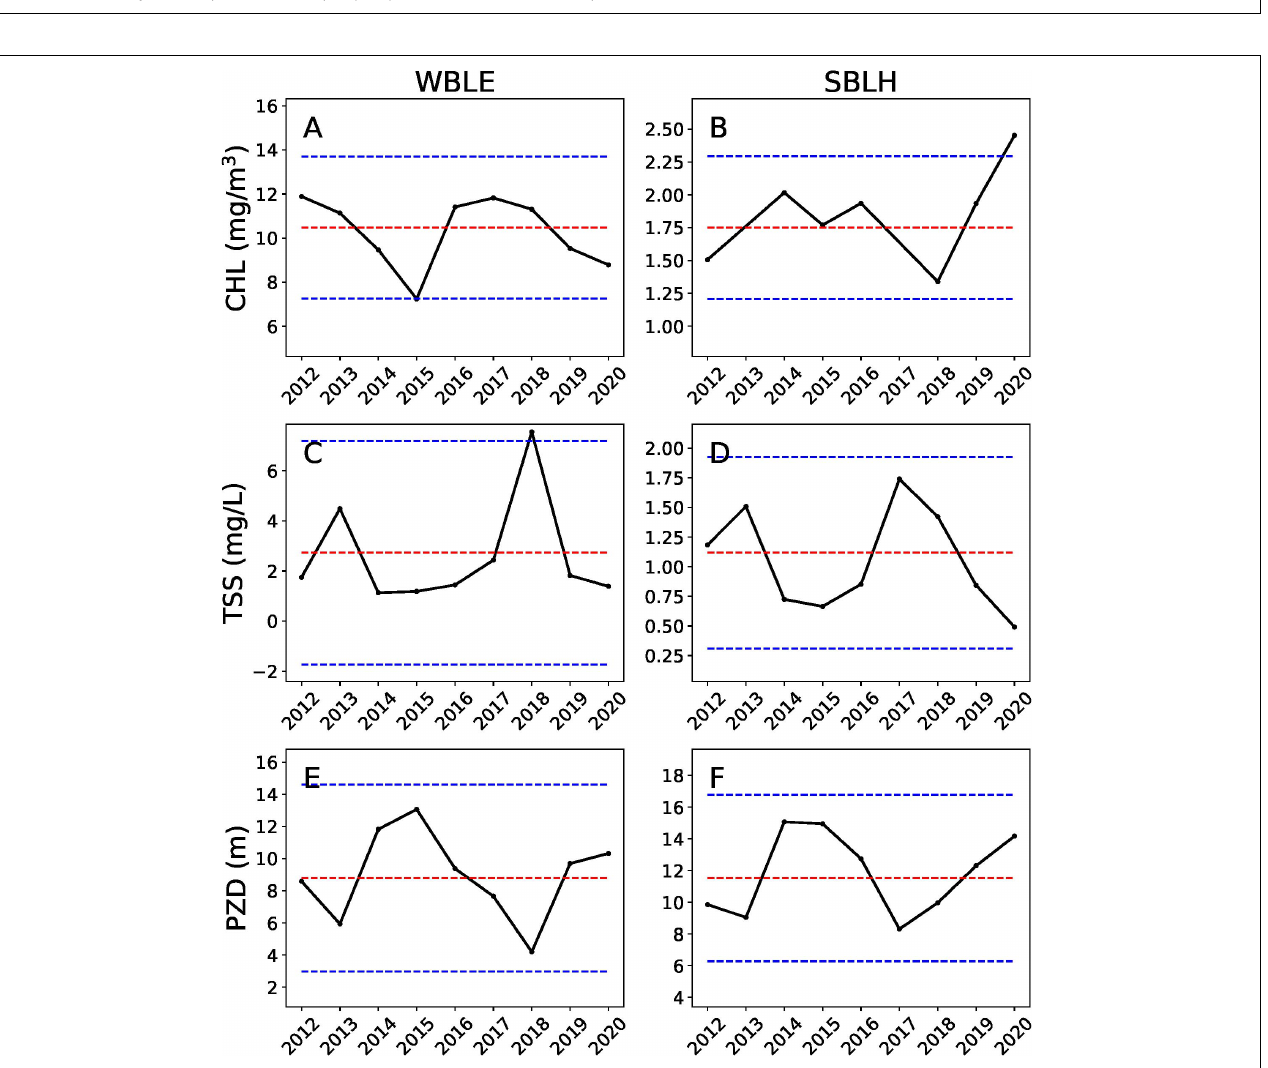
FIGURE 3 | Median April indicator values plotted over the sensor data record (2012–2020). Years in which less than 50% of the regional data pixels have data are excluded. The 2012–2019 mean is shown as the dashed red line, with the dashed blue lines representing the 2012–2019 mean plus/minus two times the 2012–2019 standard deviation. (A,C,E) The CHL, TSS, and PZD indicator time series for WBLE. (B,D,F) The CHL, TSS, and PZD indicator time series for SBLH.